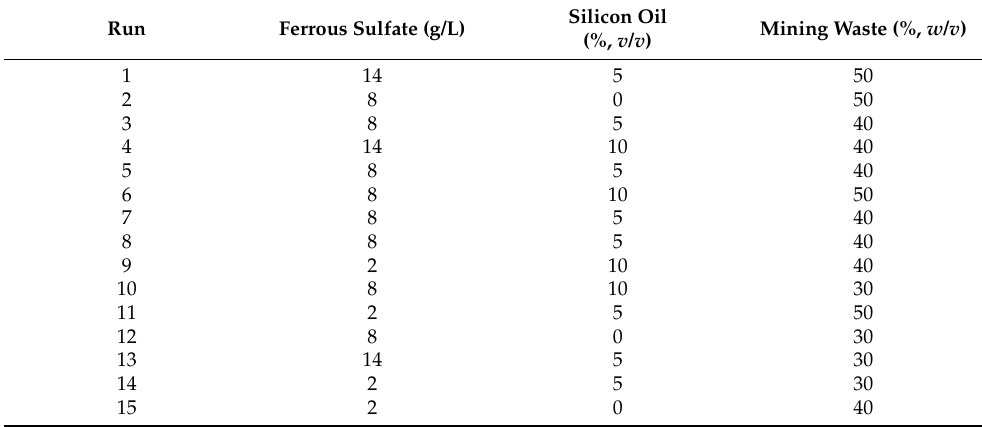
Table 1. Experimental design of the Box-Behnken response surface (Ferrous Sulfate, Silicon Oil, Mining